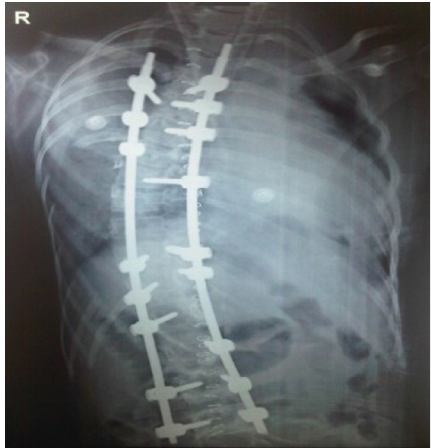
Figure 2: Preoperative MRI brainstem picture showing no abnormalities.